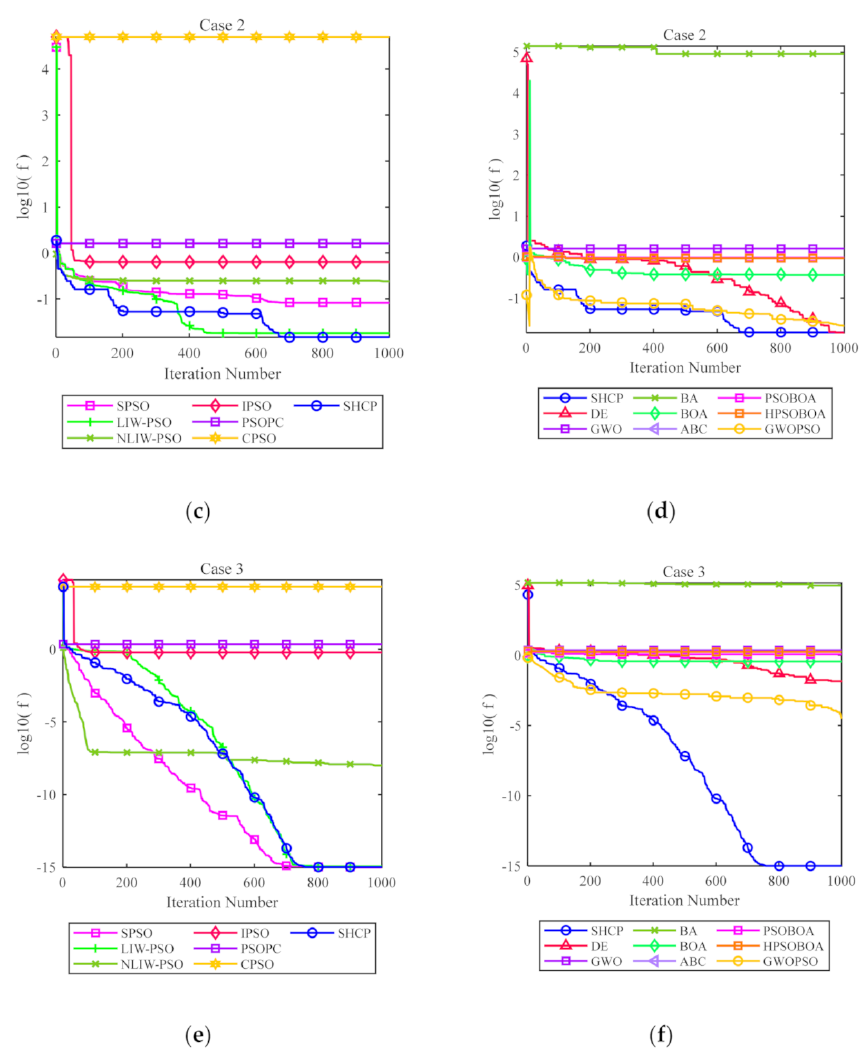
Figure 5. Convergence curves of algorithms. ( a ) Convergence curves of SHCP and PSO variants for Case 1; ( b ) Convergence curves of SHCP and meta-heuristic algorithms for Case 1; ( c ) Convergence curves of SHCP and PSO variants for Case 2; ( d ) Convergence curves of SHCP and meta-heuristic algorithms for Case 2; ( e ) Convergence curves of SHCP and PSO variants for Case 3; ( f ) Convergence curves of SHCP and meta-heuristic algorithms for Case